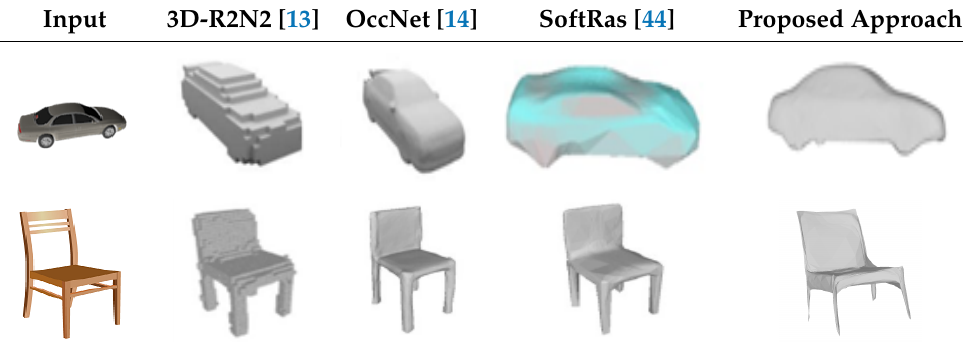
Table 2. Visual comparison with competitive